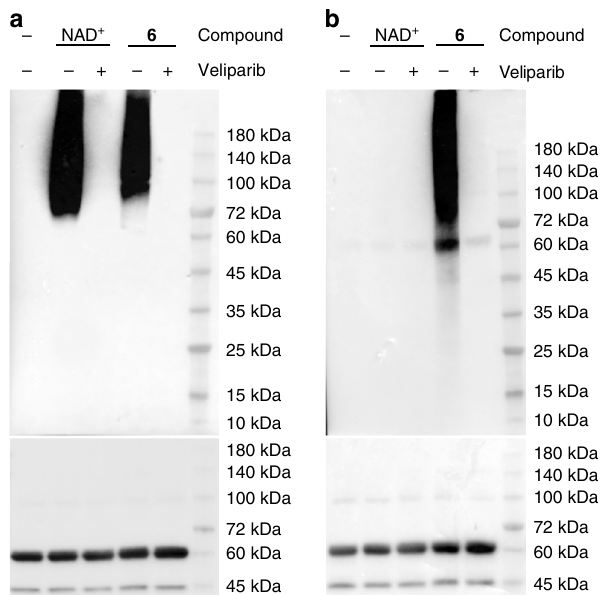
Fig. 3 Substrate activities of NAD + and 6 for human PARP1. Auto- PARylation of PARP1 with 400 µ M NAD + or 6 was analyzed by immunoblots using an anti-PAR antibody ( a ) and a streptavidin-HRP conjugate following biotin conjugation via click chemistry ( b ). PARP1 loading controls were detected by an anti-His 6 antibody. Source data are provided as a Source Data fi anti-PAR antibody can recognize the 3 ′ -azido NAD + -derived